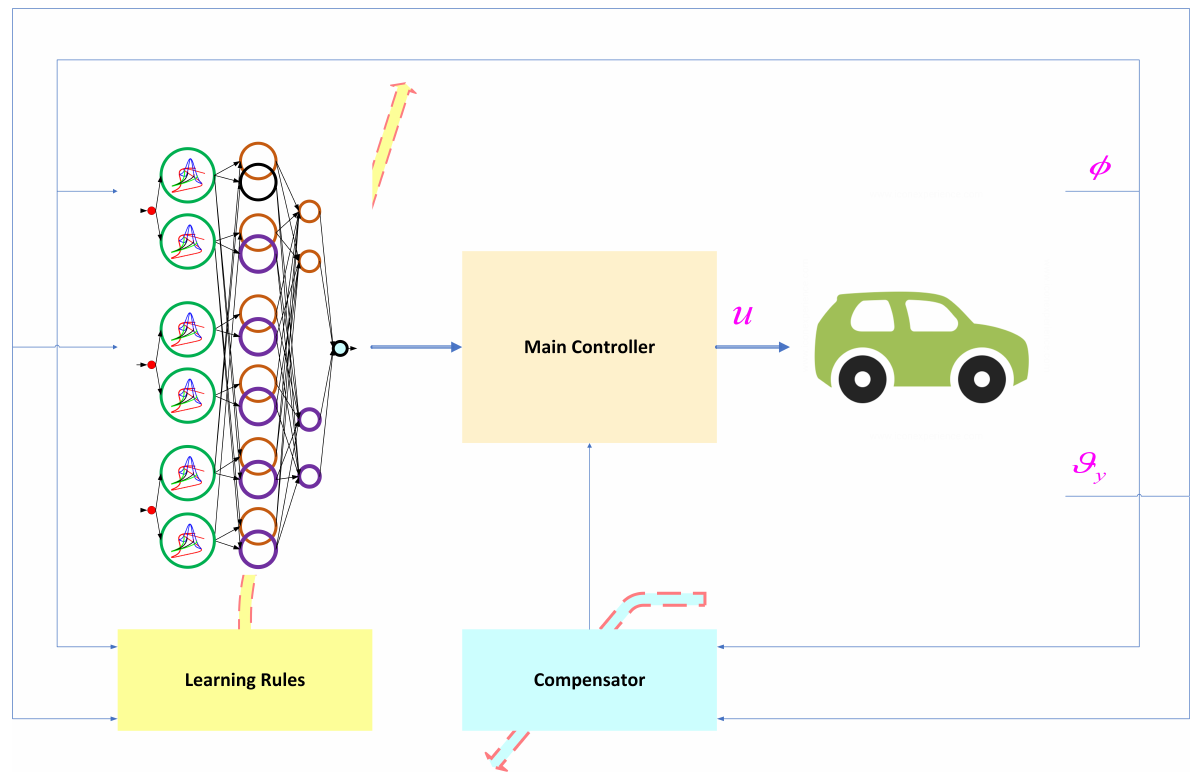
Figure 2. The general diagram of the suggested control